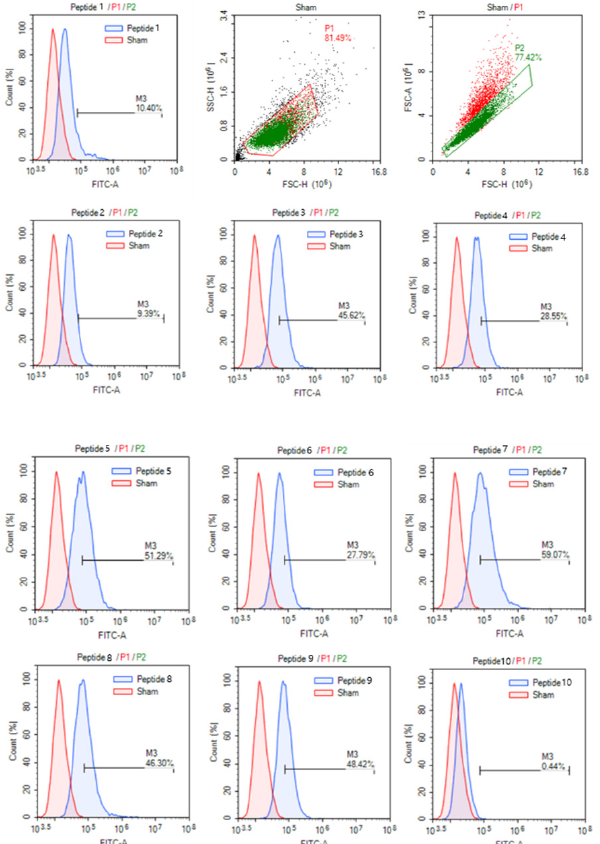
Figure 10. Cellular uptake of CPPs. Cells are treated without (sham) or with each FITC-conjugated peptide (1 µ M) for 1 h in MCF-7 cells, and the fluorescence intensity is measured using flow cytometry as described in the Materials and Methods section.